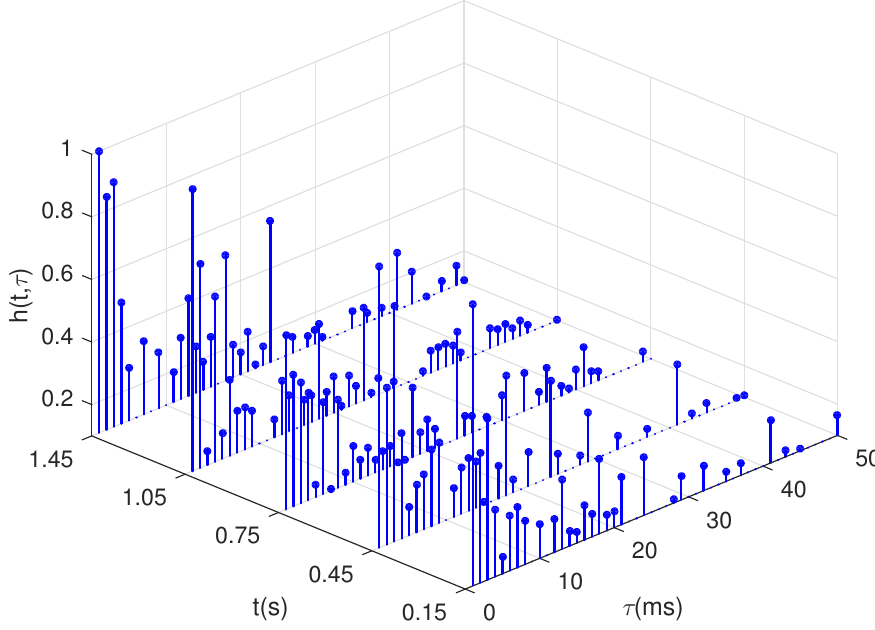
Figure 12. The channel impulsive responses in the sea